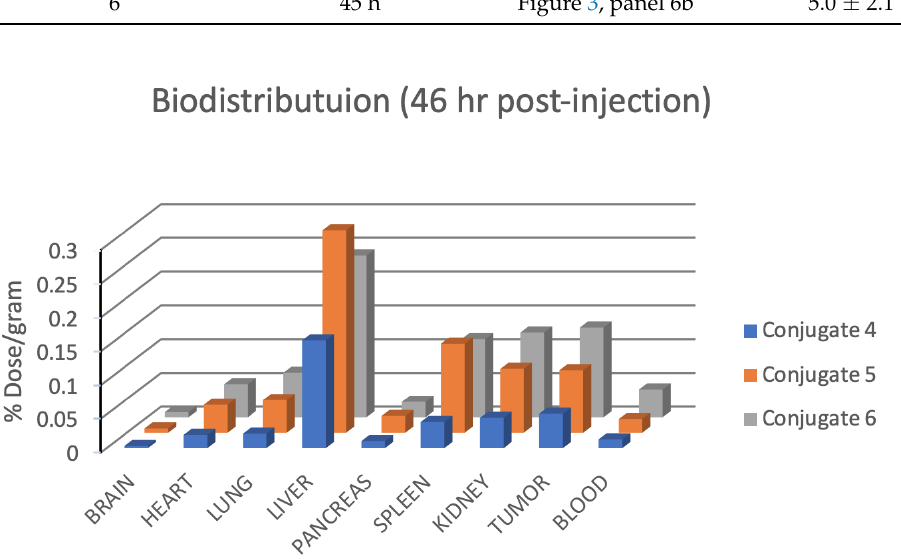
Figure 4. Biodistribution of tumor-bearing mice (as % injected dose per gram) 46 h post-injection of AuNP conjugates 4 , 5 and 6